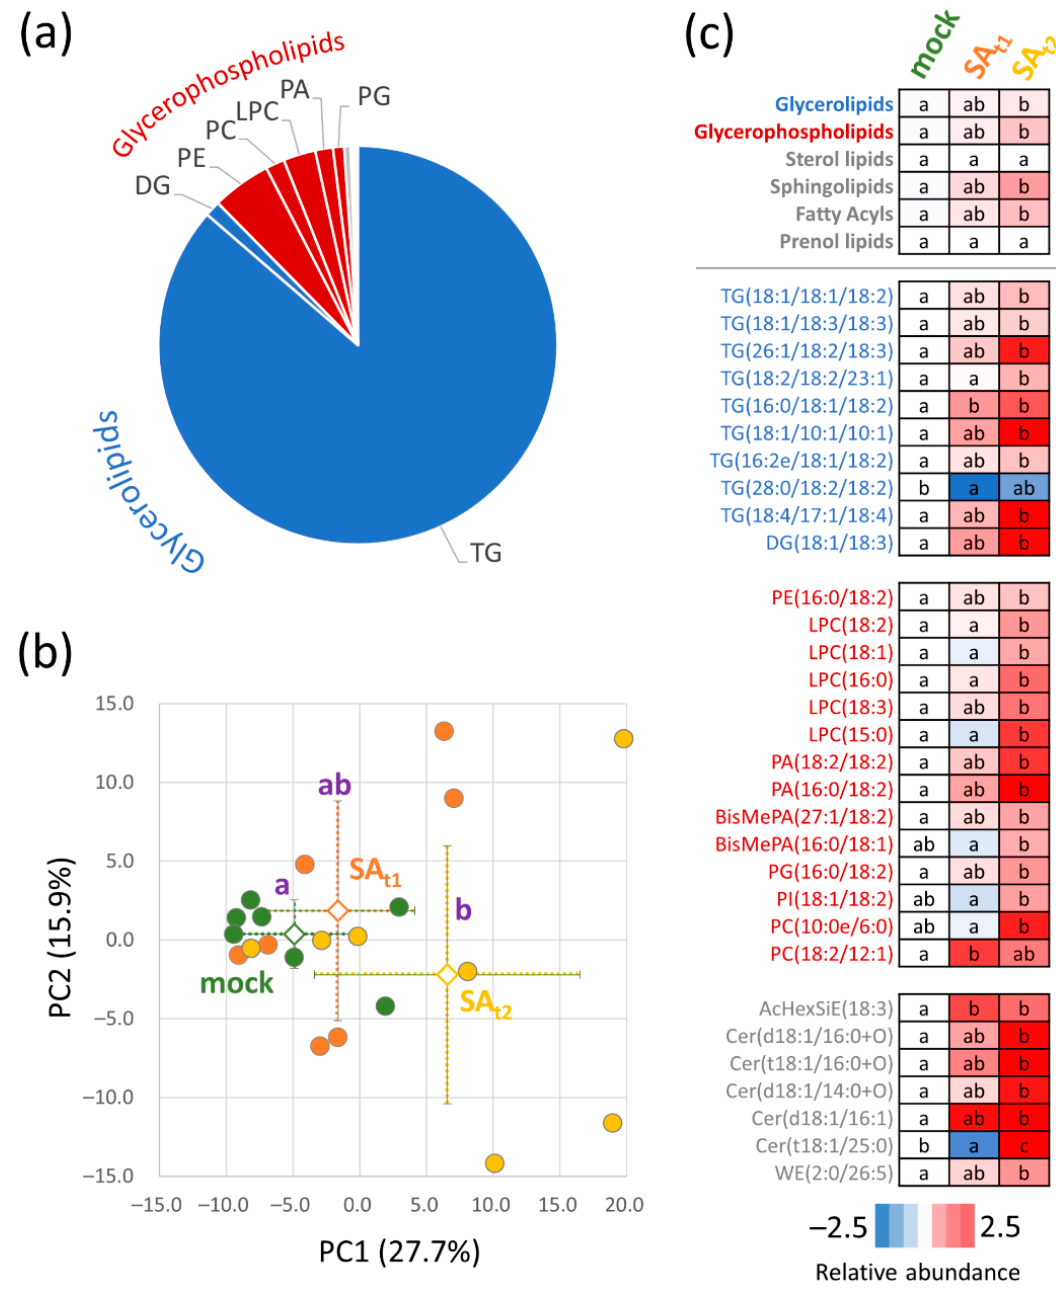
Figure 5. Lipidome profile of seeds. ( a ) The estimated seed lipid composition of mock-treated plants and corresponding PCA analysis ( b ). Based on the abundance of 250 detected lipids. Open shapes and dot lines represent means and standard deviations, respectively. ( c ) Statistically significant differences in lipid composition. Lipid classes and individual lipids are sorted according to the class and estimated abundance. Letters indicate statistically significant differences ( p < 0.05, Kruskal–Wallis and Conover’s test, p < 0.05). Results are based on seven biological replicates. Cer, ceramides; DG, diglyceride; LPC, lysophosphatidylcholine; PA, phosphatidic acid; PC, phosphatidylcholine; PE, phosphatidylethanolamine; PG, glycerophosphoglycerols; PI, phosphatidylinositol; SiE, sitosterol esters; TG, triglyceride; WE, wax ester. For details, see Supplementary Table S2.